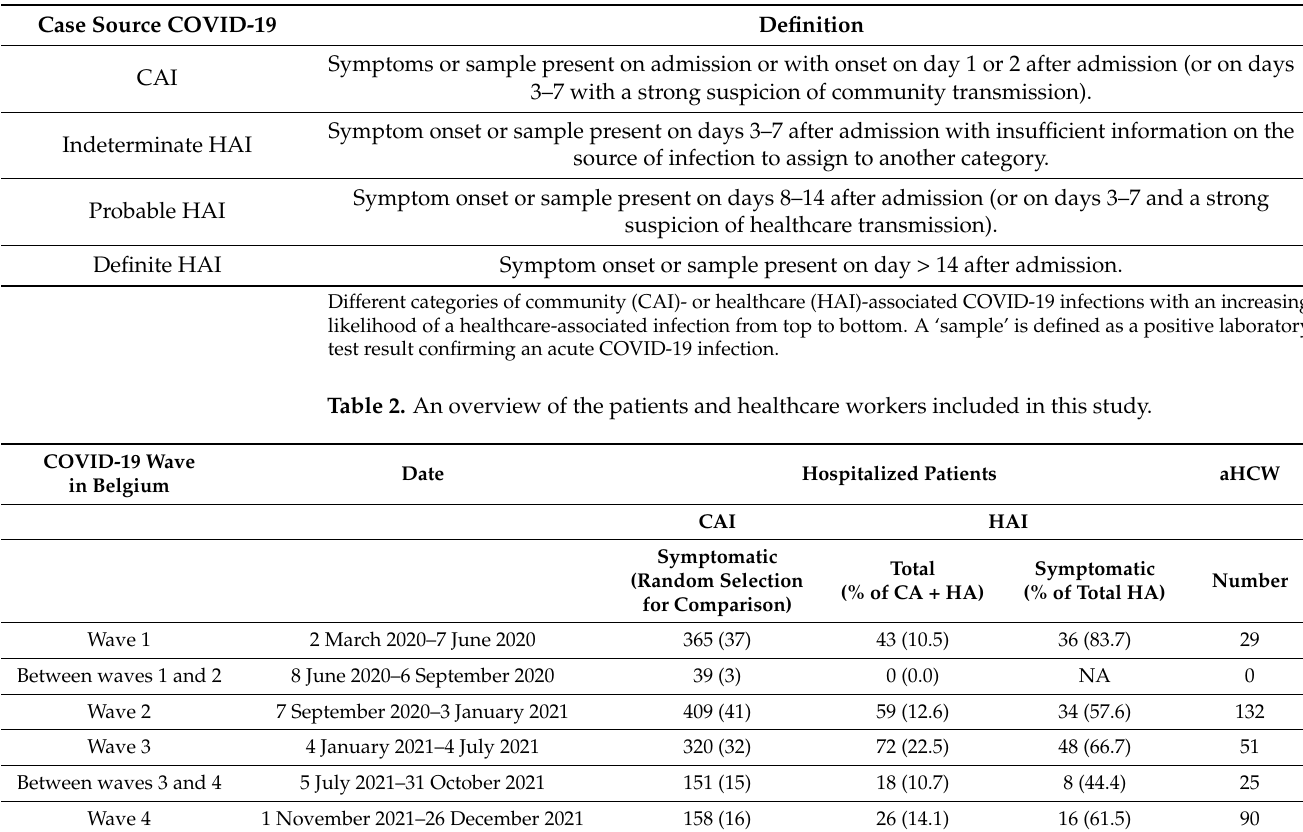
Table 1. ECDC case source definitions of COVID-19 [12].